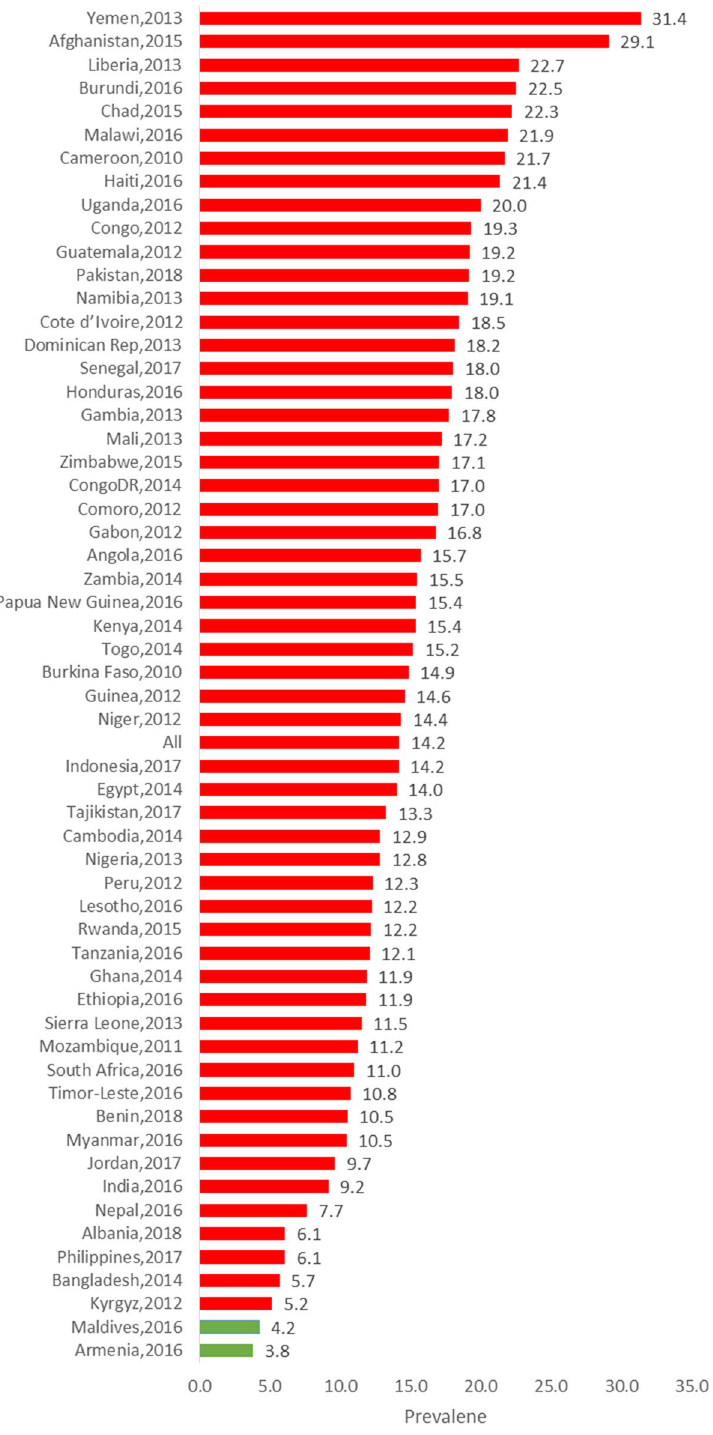
Figure 2. Prevalence of diarrhoea by countries (DHS